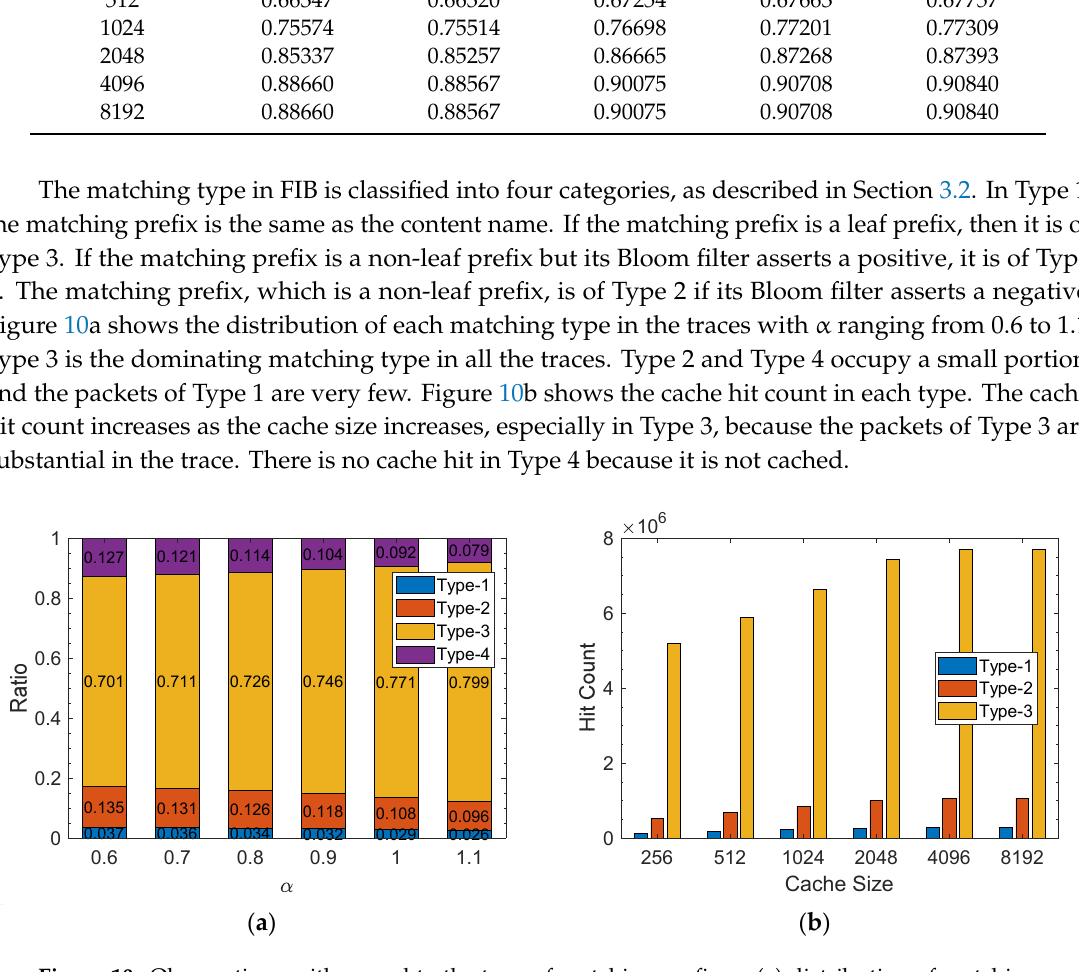
Figure 10. Observations with regard to the type of matching prefixes: ( a ) distribution of matching prefixes in the traces with α , from 0.6 to 1.1; ( b ) cache hit count on matching prefix